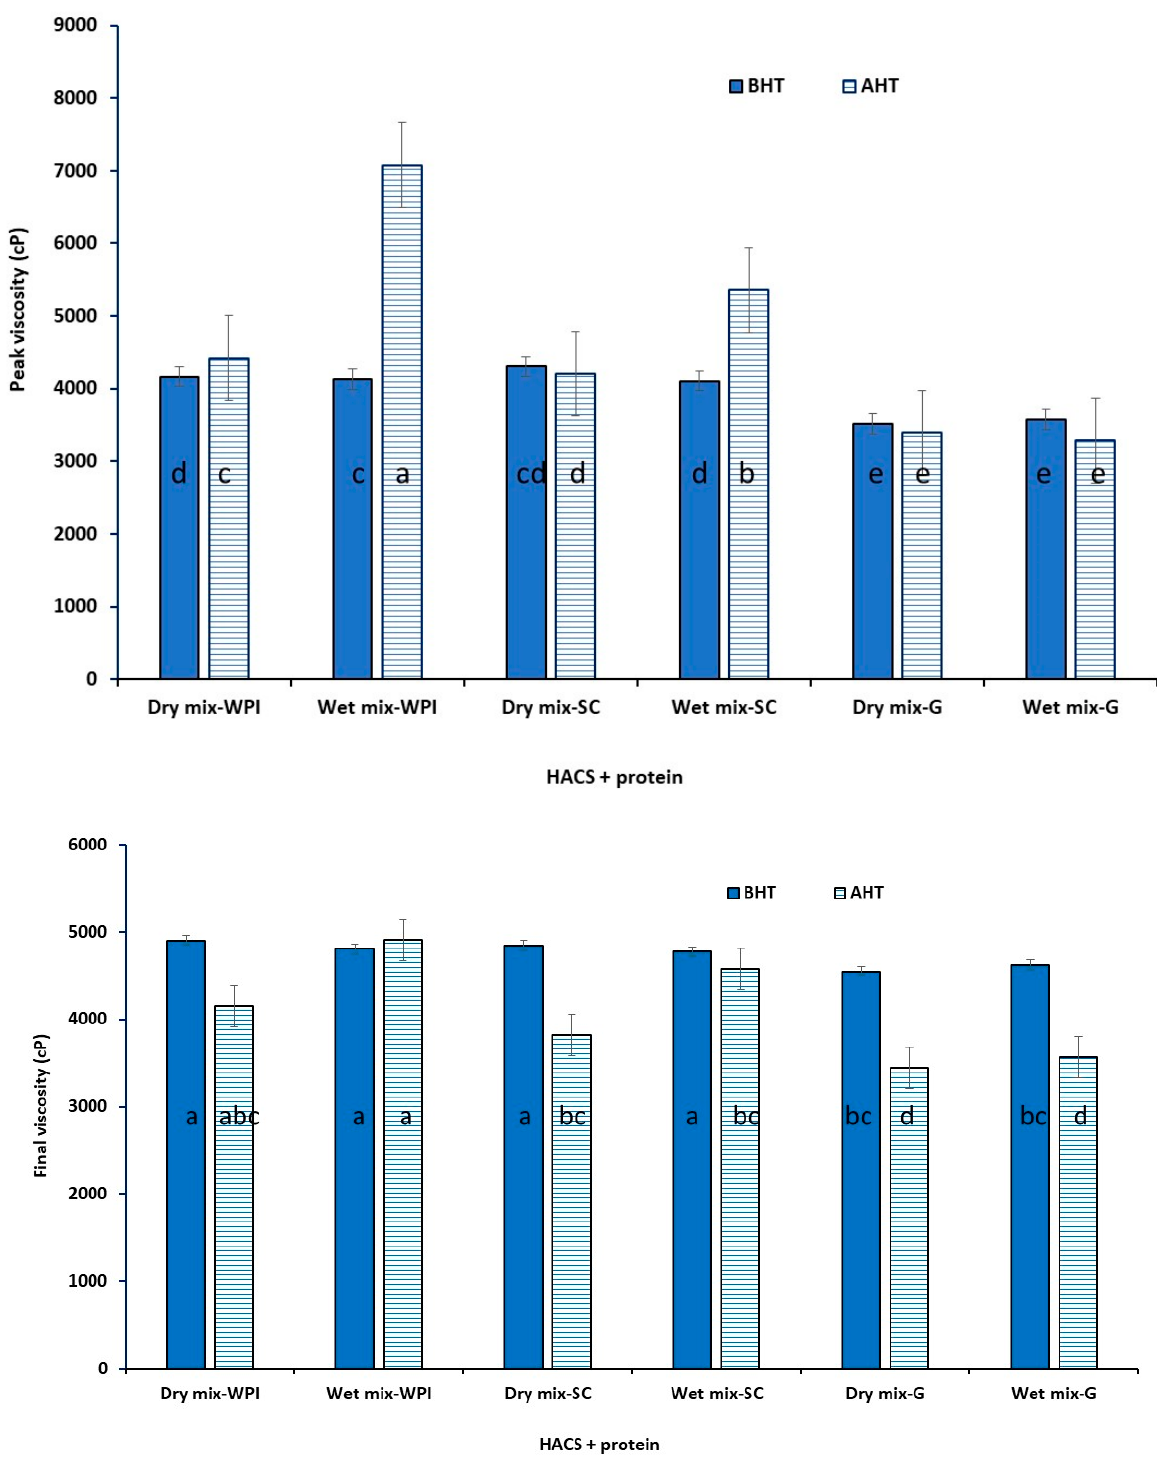
Figure 2. Peak and final viscosity of high amylose corn starch (HACS) and the protein mixtures before heat treatment (BHT) and after heat treatment (AHT). The different letters on the columns indicate statistically significant differences ( p < 0.05).